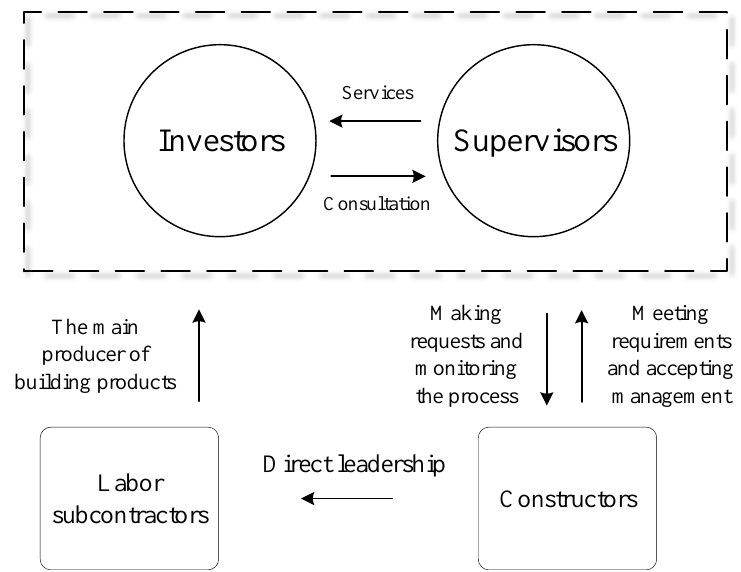
Figure 1. Tripartite relationship of investors–constructors–labor constructors.